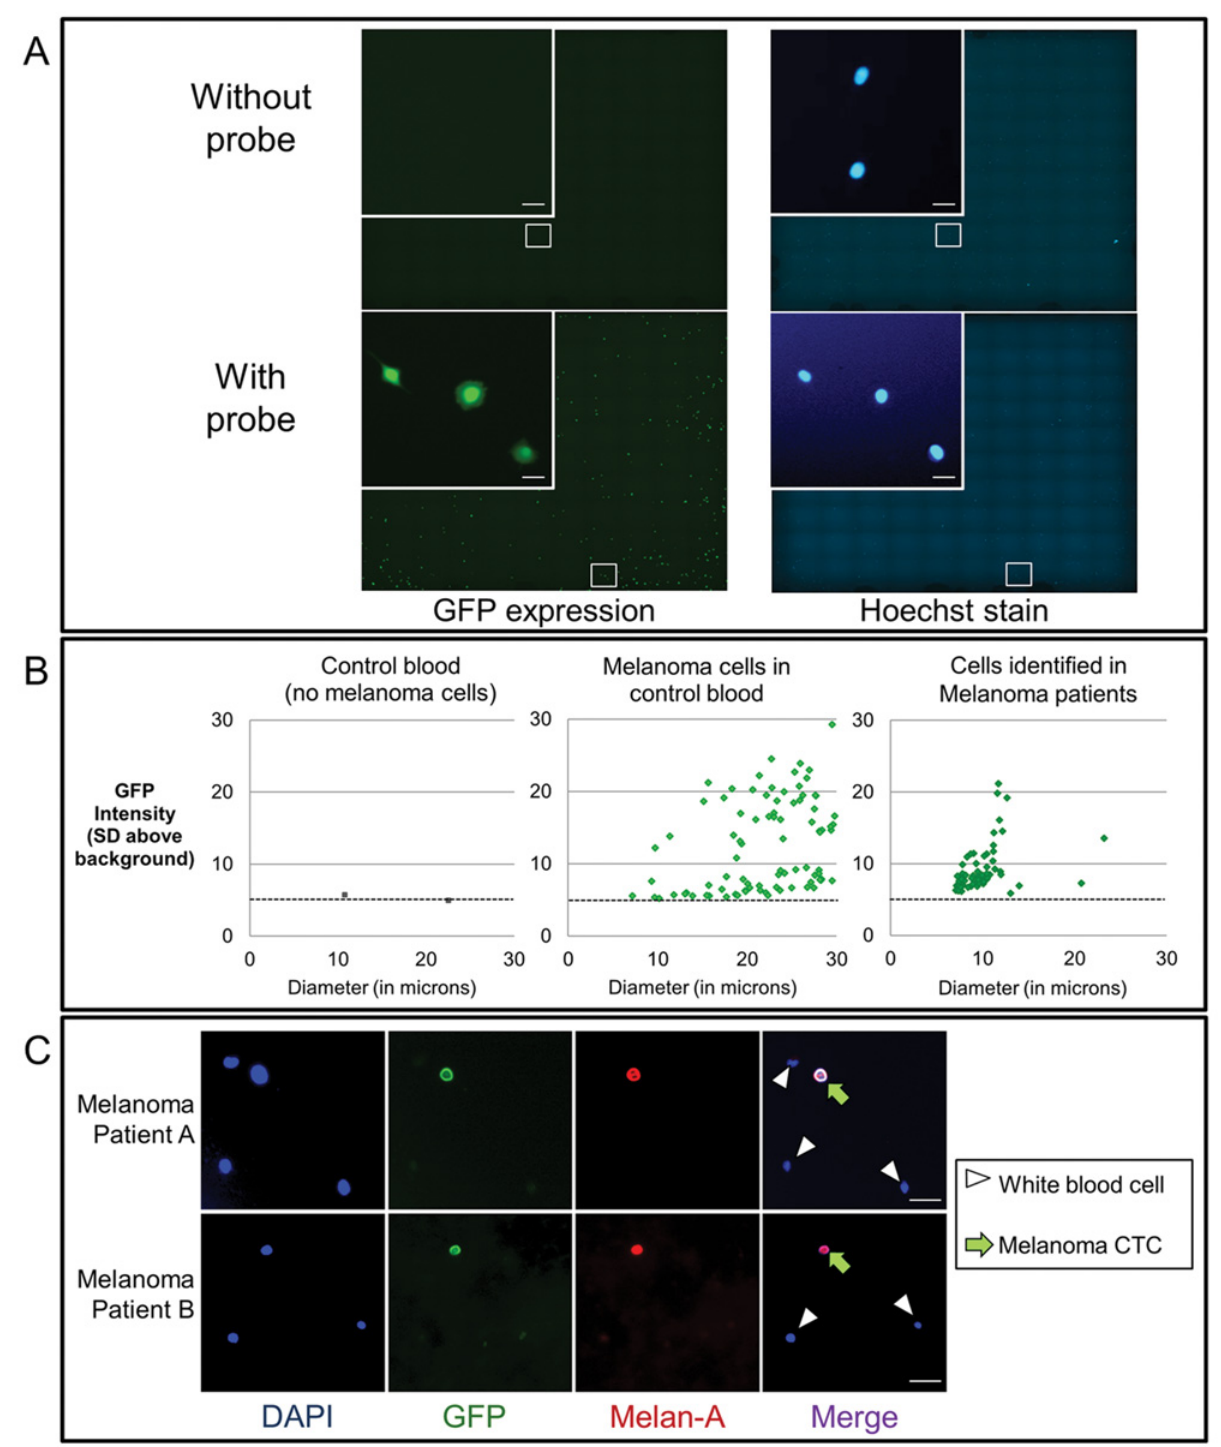
Fig 2. Integration of the viral probe with a semi-automated, computer-driven image acquisition and analysis system. (A) Melanoma cells (A375P cells shown here as a representative example) incubated with the probe for 24 hours were visualized under fluorescent microscopy. Tiled images were taken for each well. Hoechst dye was added before image acquisition to delineate nucleated cells, which take up the dye and emit blue fluorescent signal under UV light. Bar, 30um. (B) Scatter plots showing individual cells, plotting size (X-axis) and fluorescent intensity (standard deviations (SD) above background) (Y- axis) identified by the imaging program. Control blood studies from a single subject with spiked melanoma cells (middle graph) or without spiked cells (left